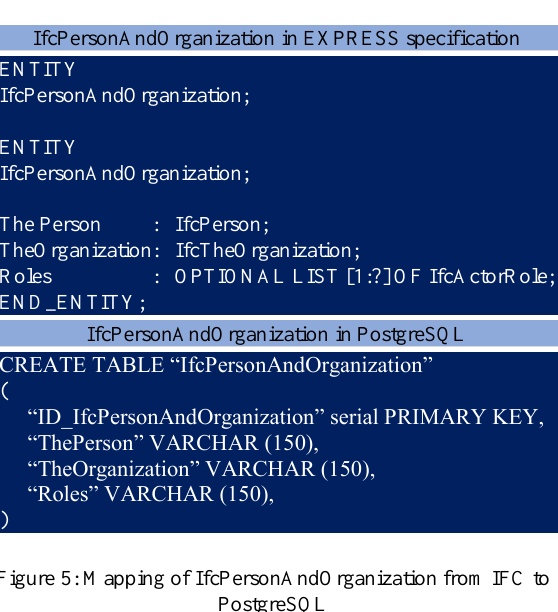
Figure 5: Mapping of IfcPersonAndOrganization from IFC to PostgreSQL